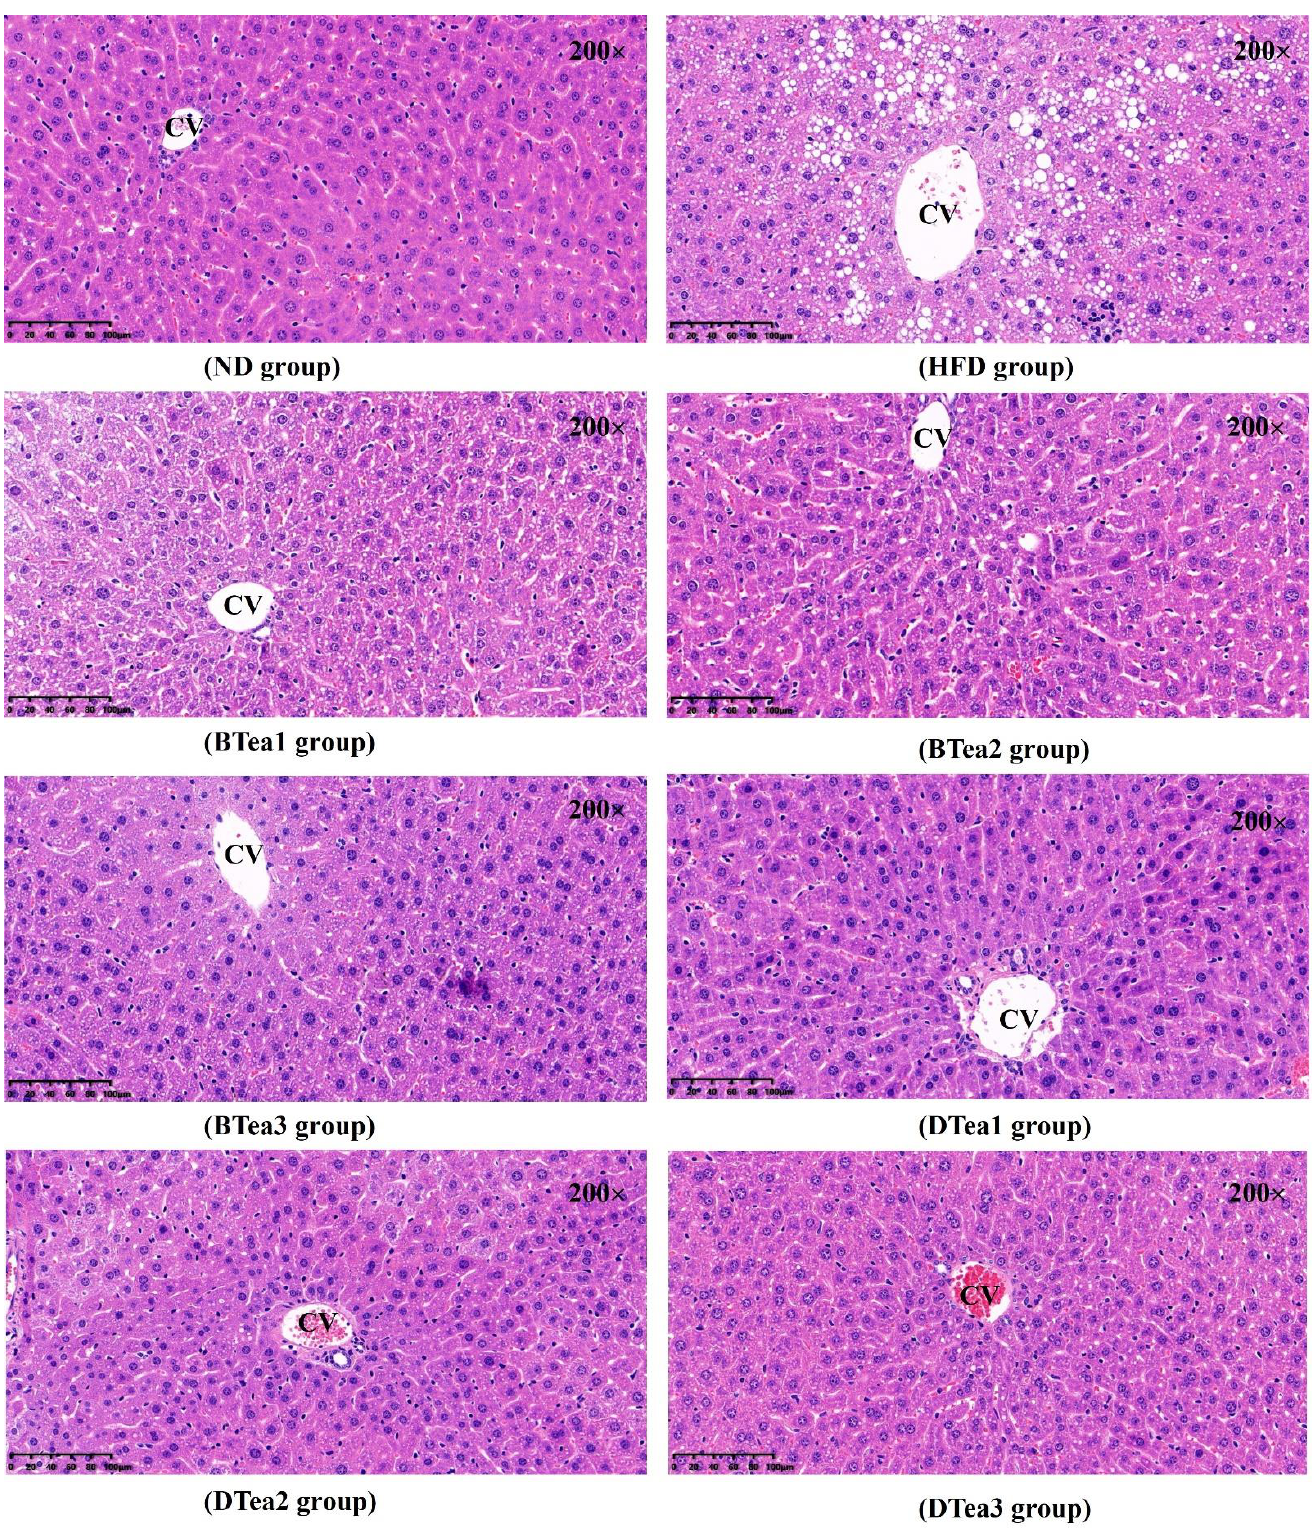
Figure 5. The histopathologic evaluations in hepatic tissue stained with haematoxylin and eosin (H&E) for all groups (magnification: 200, scale bar: 100 µm). ND, the control group (normal diet group); HFD, the model group (high-fat diet group); BTea1, selenium-enriched black tea; BTea2, Dianhong tea; BTea3, Yingde black tea; DTea1, Fu brick tea; DTea2, Liupao tea; DTea3, selenium- enriched dark tea.